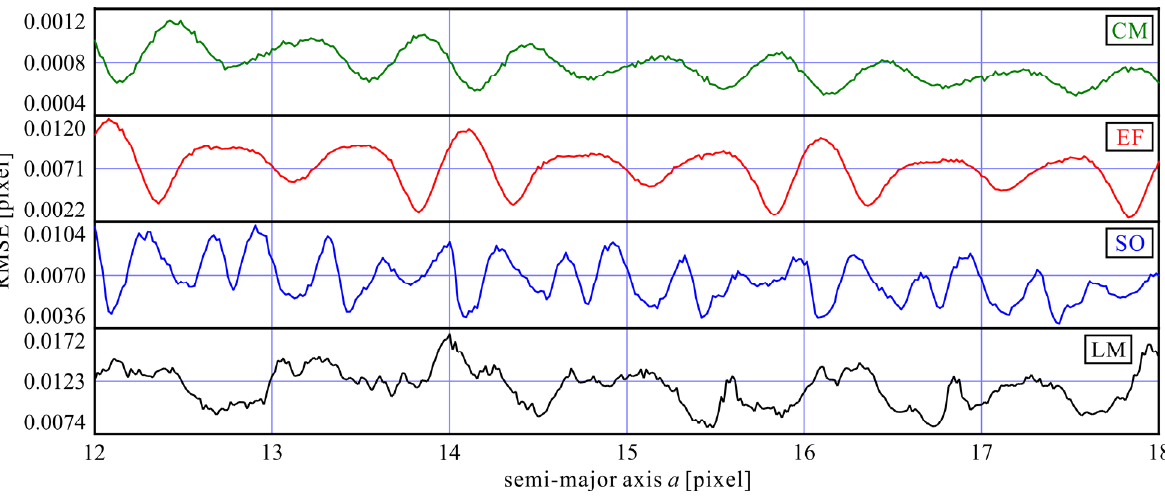
Figure 5. RMSE of the center location measurement of an ellipse (12 pixels  a  18 pixels, f = 0.25,  = 0.0º)